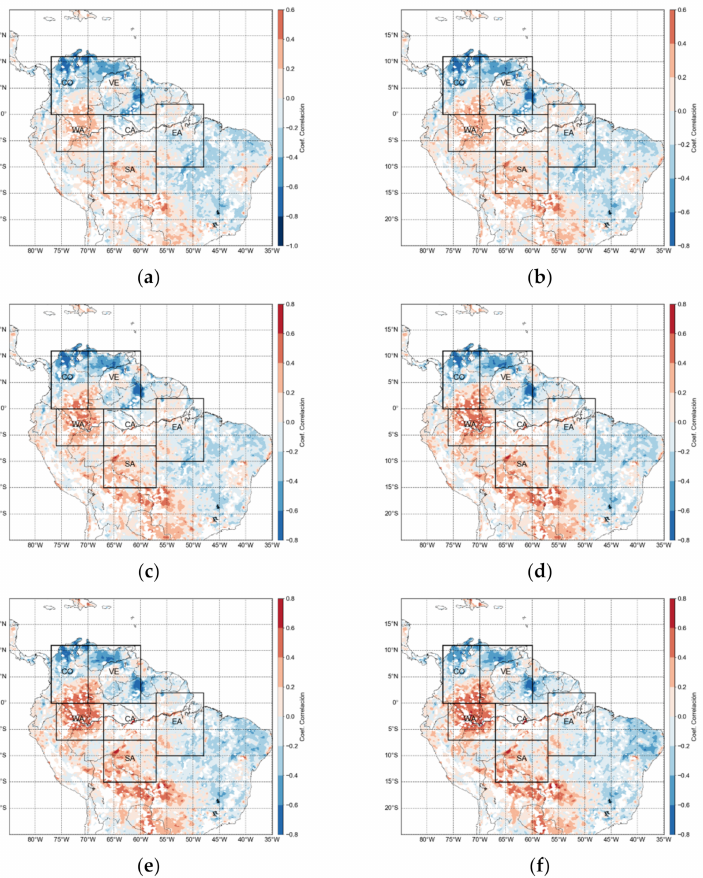
Figure 8. Spatial lagged-correlations between the CP index (leading) and standardized SMOS (lagging) monthly data: ( a ) 0 lag; ( b ) 1-month lag; ( c ) 2-month lag; ( d ) 3-month lag; ( e ) 4-month lag; and ( f ) 5-month